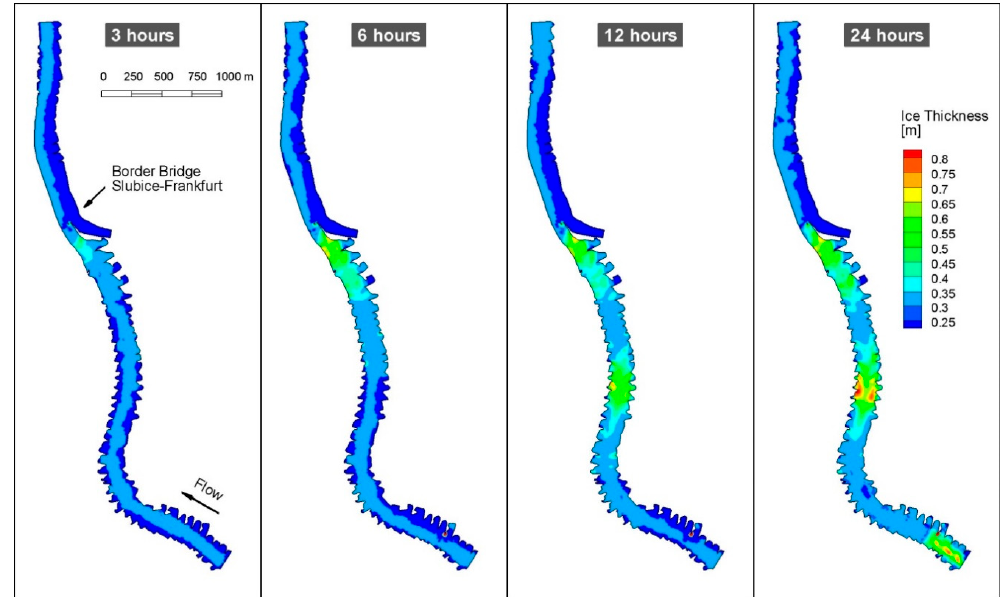
Figure 4. Simulated ice thickness distribution in the Lower Odra River in the vicinity of the S ł ubice-Frankfurt Bridge (581–586 km). Słubice-Frankfurt Bridge (581–586